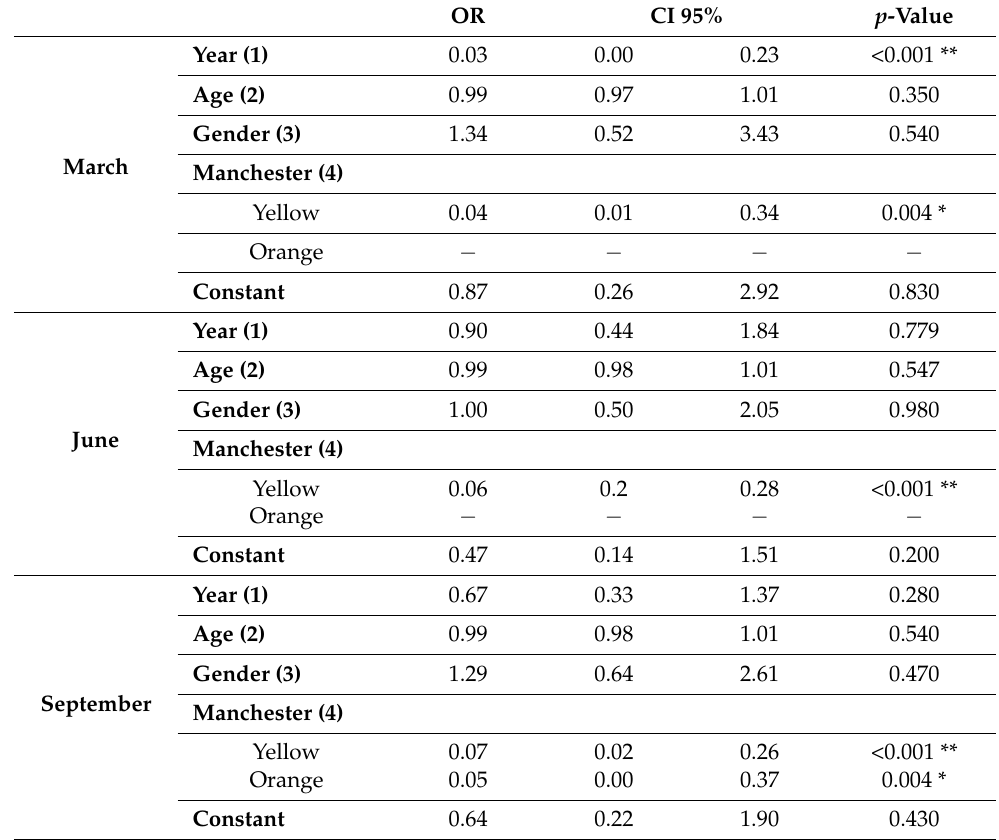
Table 2. Multivariate analysis of association between inappropriate cases by study